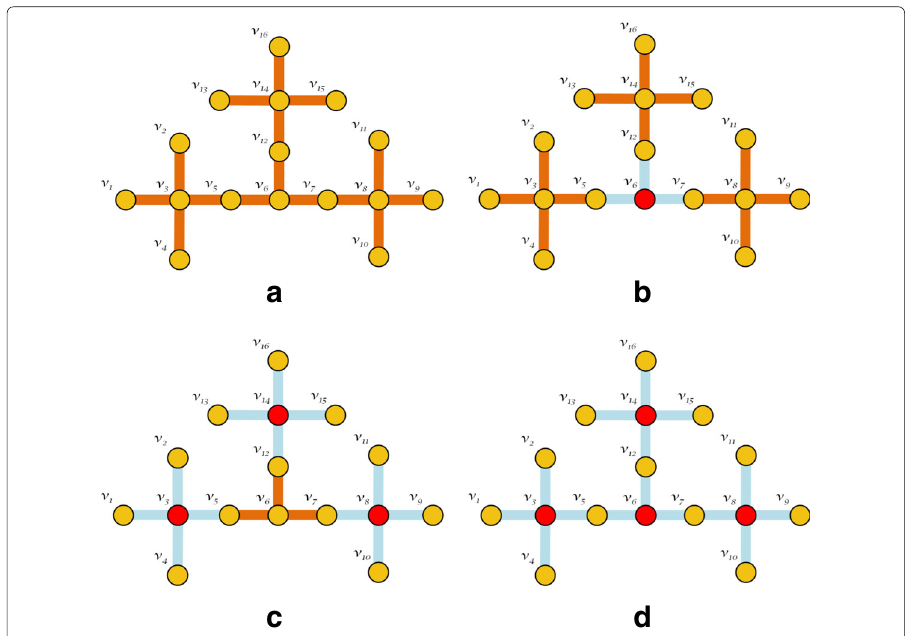
Fig. 2 Schematic Illustration of Finding Centers and Bridges in Graph. The red dots represent the protected nodes. Shaded lines represent the removed edges. a Initial Input Graph. b Protecting the Bridges , nodes with highest value of Random Walk Normalized Fiedler Vector ( μ ). c Protecting the Centers , nodes with highest value of Degree Centrality ( d ). d Combining (b) and (c) objectives in